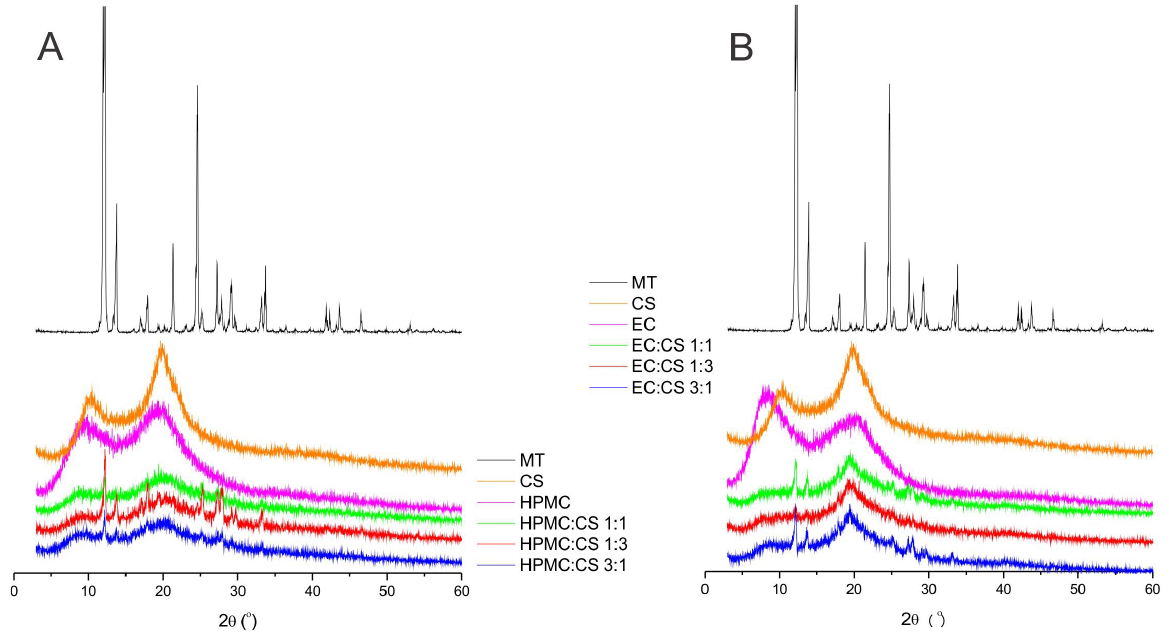
FIGURE 4 - XRD of microparticles and their constituents: (A) HPMC and CS samples; (B) EC and CS samples. MT: metronidazole; CS: chitosan; HPMC: hydroxypropyl methylcellulose; EC: rthylcellulose.